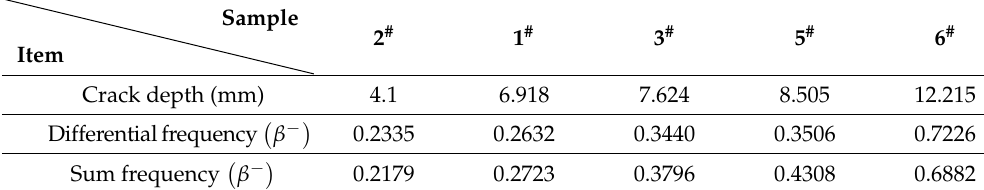
Table 3. Nonlinear coefficient for crack depth.